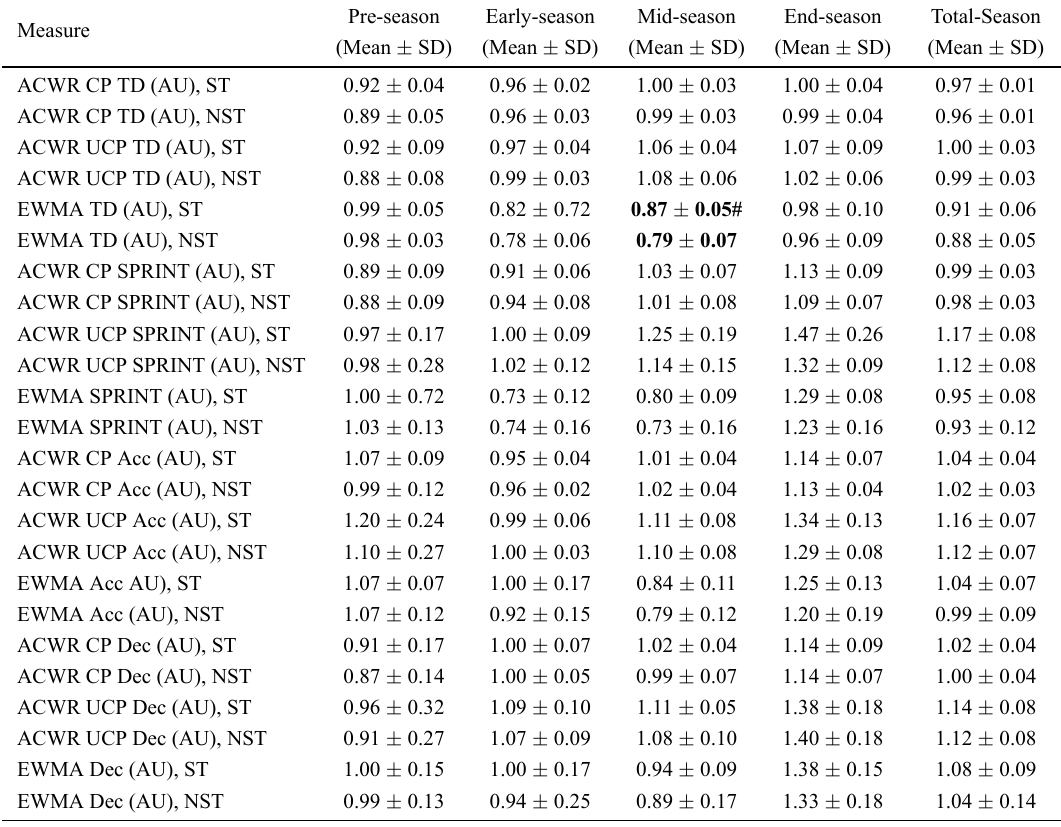
Table 2. Differences between starters and non-starters during different periods of the season.